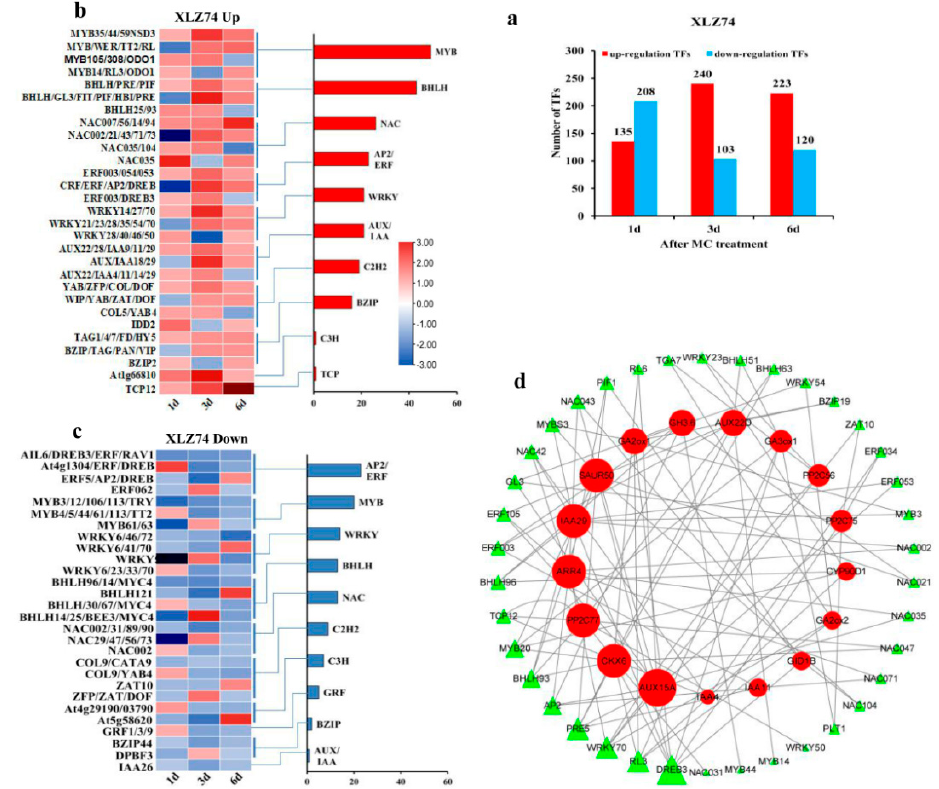
Figure 10. The number and expression pattern of the up- and downregulated transcription factors (TFs) in XLZ74. ( a ) The total number of up- or downregulated TFs in XLZ74 at three time points after MC treatment. ( b ) The expression pattern of representative upregulated TFs in XLZ74. ( c ) The expression pattern of representative downregulated TFs in XLZ74. ( d ) The co-expression network of hormone-related genes and TFs in XLZ74. The larger triangles on TFs and circles on hormone-related genes indicated the stronger connectivity, which meant that the corresponding genes were more important for the interaction of TFs with hormone metabolism and signaling genes.